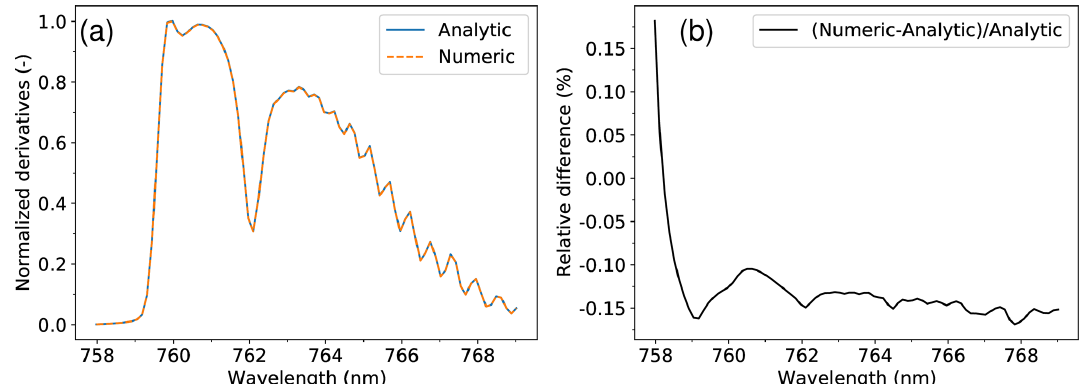
Figure 8. (a) Derivative of the reflectance to the cloud height, d R/ d z , for a scene with a Lambertian cloud, calculated using the semi- analytical method (Eq. 29) and the numerical method. The derivative is normalized to the maximum value calculated using the numerical method. (b) Relative difference (in percent) between semi-analytical and numerical derivatives. The steep change in the relative difference at 758nm is caused by the fact that the derivative is very small where the O 2 absorption approaches zero. The geometry is as follows: nadir view with a solar zenith angle of 30 ◦ . The cloud fraction is 1, and the Lambertian cloud albedo is 0.8.